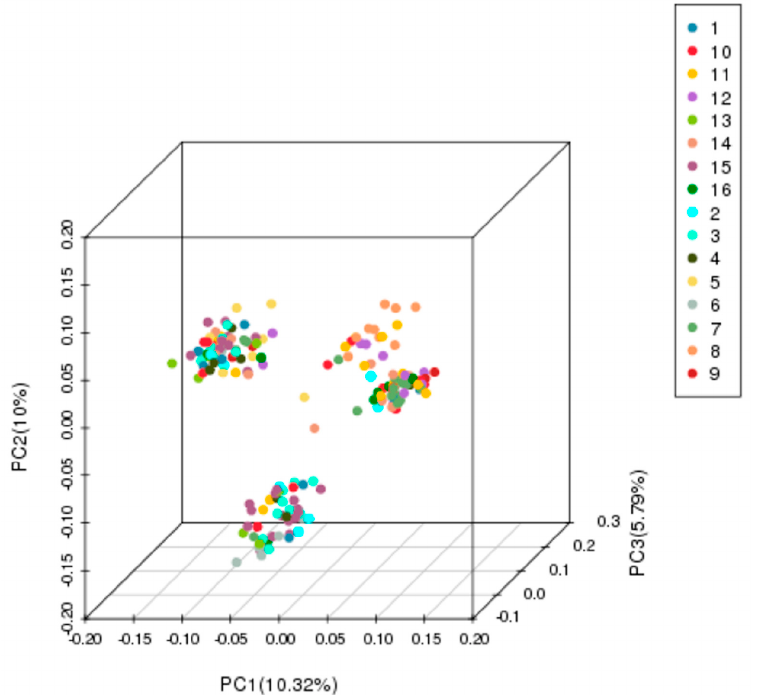
Figure 4. A neighbor joining dendrogram showing the genetic affiliation of the 179 persimmon germplasms. All germplasms were divided into four groups (I, II III, and IV).